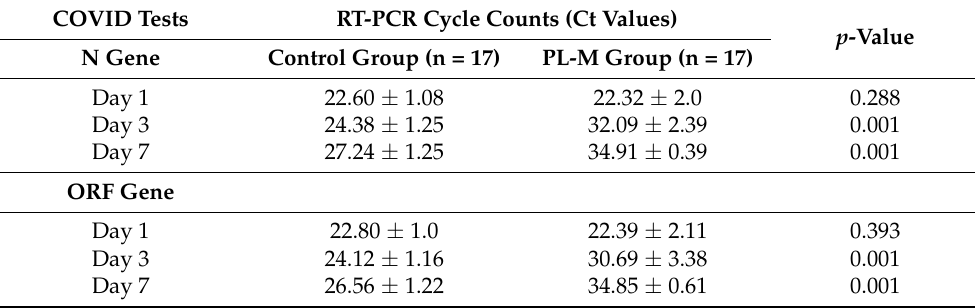
Table 2. RT-PCR cycle counts for N and ORF gene at different visits.